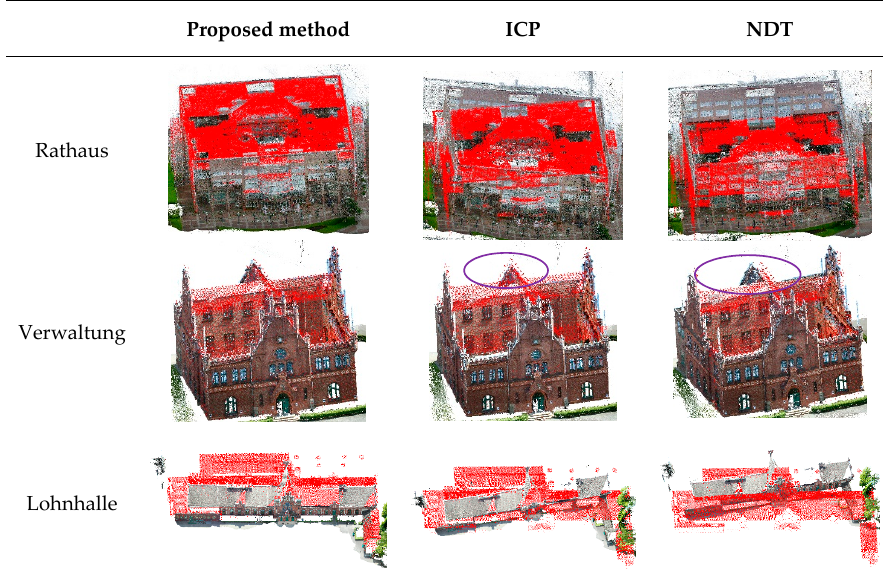
Figure 7. Fusion results of the proposed method compared with the ICP and NDT methods. Red points are building point cloud from open LiDAR data. Textured points are façade point cloud generated from ground images.